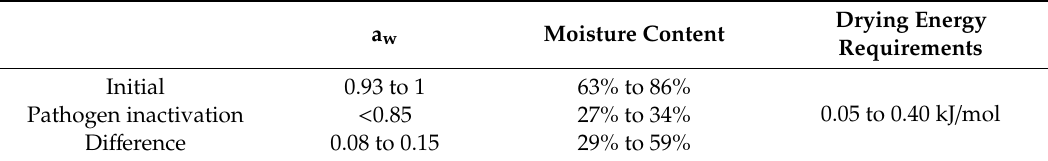
Table 5. Calculation of the energy requirements for drying fresh feces from an initial moisture content of 63% to 86% to the moisture content corresponding to a w of 0.85 at a temperature range of 15–35 ◦ C. The relationship between a w and moisture content calculated using the GAB relationship and the relationship between moisture content and the heat of sorption calculated with the fitted relationship described in Figure 4. Drying a w Moisture Content